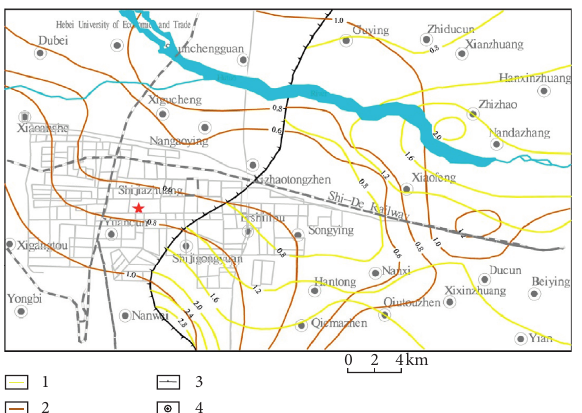
Figure 3: Strontium distribution in shallow and deep groundwater: (1) contour lines of strontium content in shallow water; (2) contour lines of strontium content in deep water; (3) boundary of the drainage area; and (4)